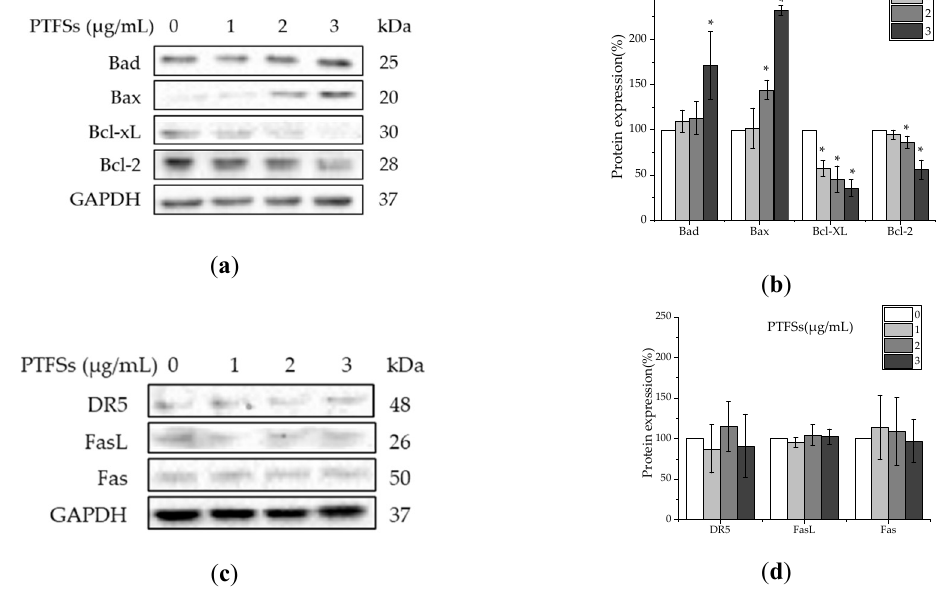
Figure 5. The effects of PTFSs on key proteins in intrinsic and extrinsic apoptotic pathways in A2780/CP70 cells. ( a ) Cells were treated with PTFSs (0, 1, 2, 3 μg/mL) for 24 h. Intrinsic apoptotic pathway-related proteins Bad, Bax, Bcl-xL, Bcl-2, and GAPDH protein expression were detected by Western blotting. ( c ) Cells were treated with PTFSs (0, 1, 2, 3 μg/mL) for 24 h. Extrinsic apoptotic pathway related proteins Fas, DR5, and FasL. ( b, d ) The changes in the protein levels induced by PTFSs were expressed as quantification histograms with error bars. GAPDH protein expression was detected by Western blotting and utilized for an endogenous reference to standardize protein levels. * p < 0.05 versus control. Cells treated with culture medium containing 0.01% DMSO were used as the control.